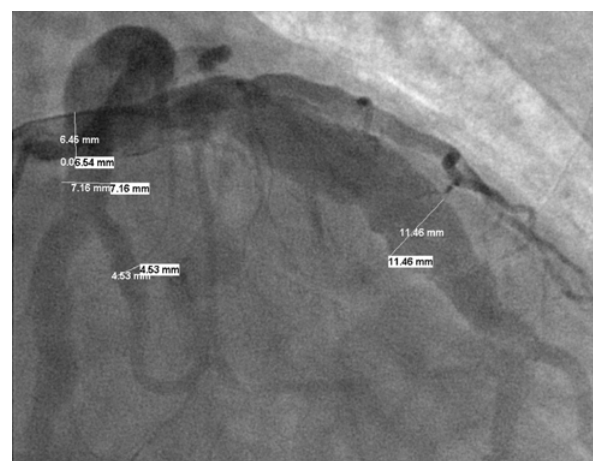
Fig. 2 - Angiografia coronária demonstrando as artérias coronárias esquerda, descendente anterior e circunflexa com dilatações